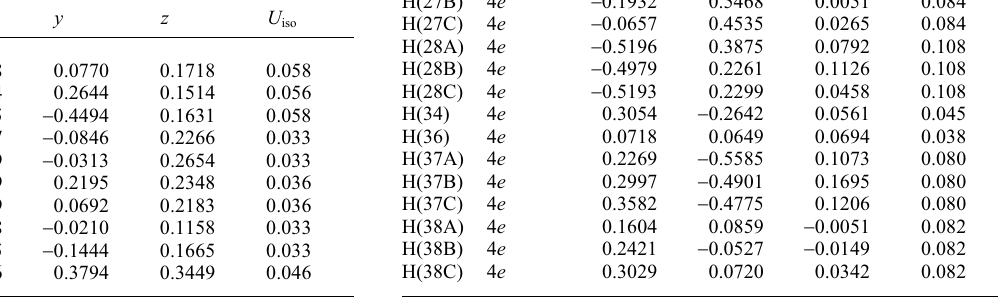
Table 3. Atomic coordinates and displacement parameters (in Å 2 )